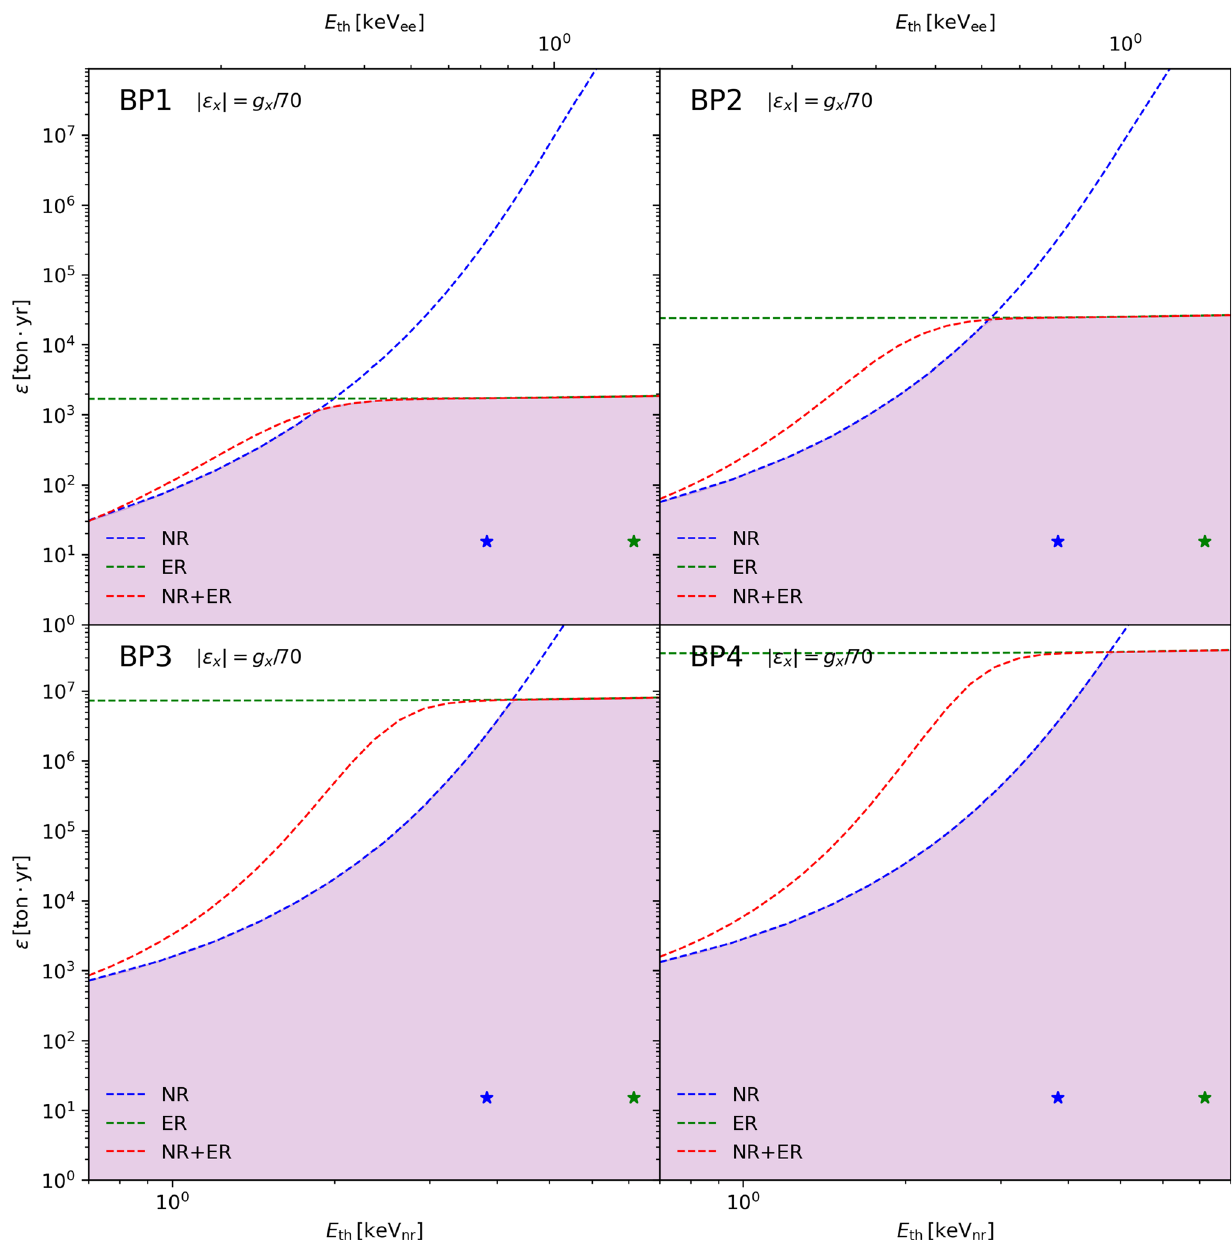
Fig. 13 The same as in Fig. 11 but for